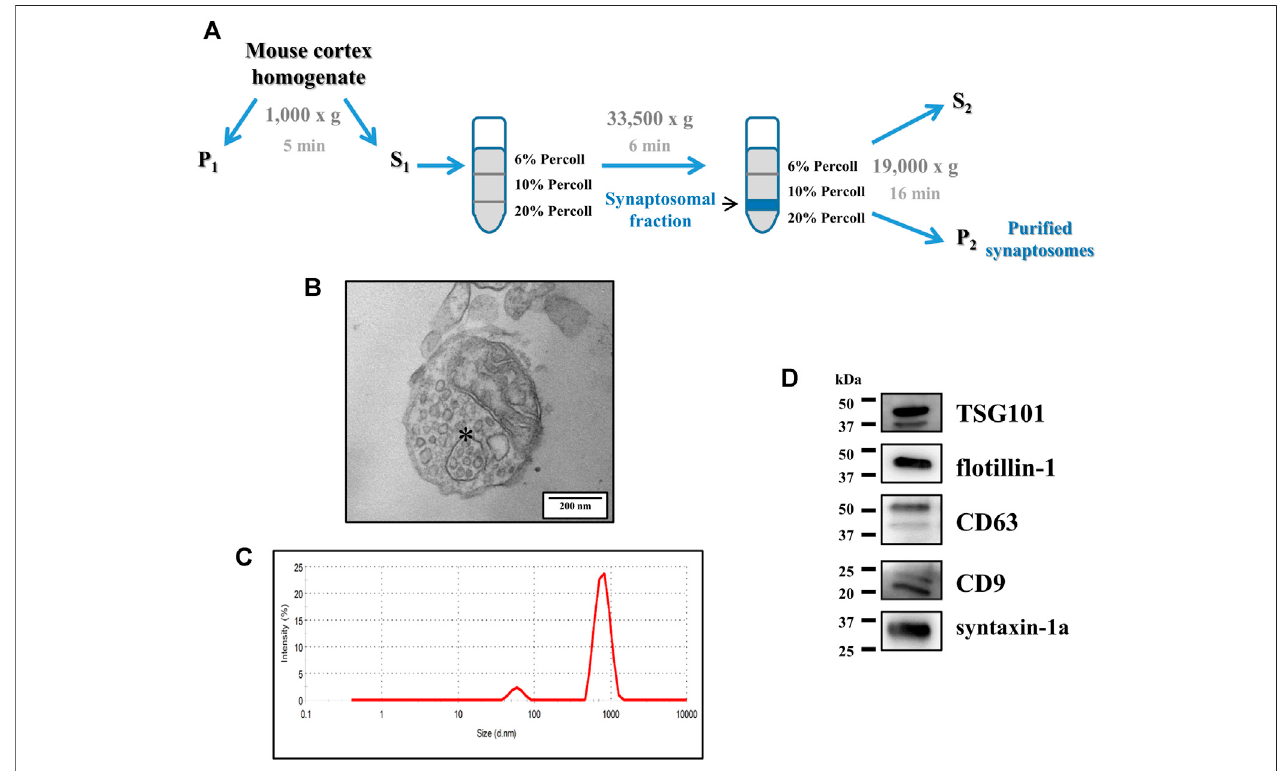
FIGURE 1 | Structural analysis of puri fi ed synaptosomes isolated from the mouse cortex. (A) Schematic representation of the discontinuous Percoll gradient isolation procedure of the puri fi ed synaptosomes from the mouse cortical homogenate. For further details, see the Methods section. (B) Ultrastructural analysis of synaptosomes by transmission electron microscopy (TEM). The fi gure shows an isolated synaptosome, containing multiple vesicles, a mitochondrion, and a multivesicular body – like organelle (asterisk). Scale bar: 200 nm. The image is representative of the TEM analysis of n (cid:1) 5 different synaptosomal preparations. (C) Size distribution of synaptosomes assessed using a Zetasizer Nano ZS90 particle sizer. The curve is representative of the analysis of n (cid:1) 5 different synaptosomal preparations. (D) Western blot analysis of the exosomal markers TSG101, fl otillin-1, CD63, and CD9 in cortical synaptosomal lysates (5 μ g/lane). Syntaxin-1a was used as a synaptosomal marker. The image is representative of the analysis of n (cid:1) 6 synaptosomal lysates.